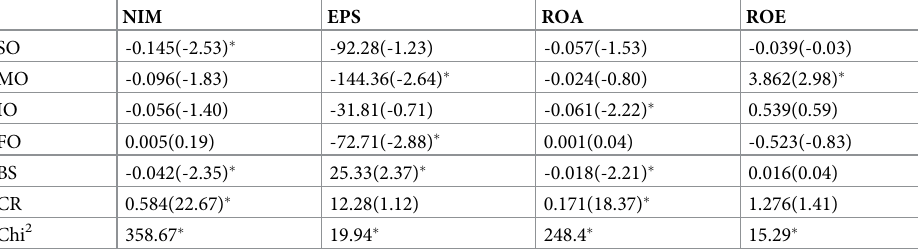
Table 9. Random-effects ML regression